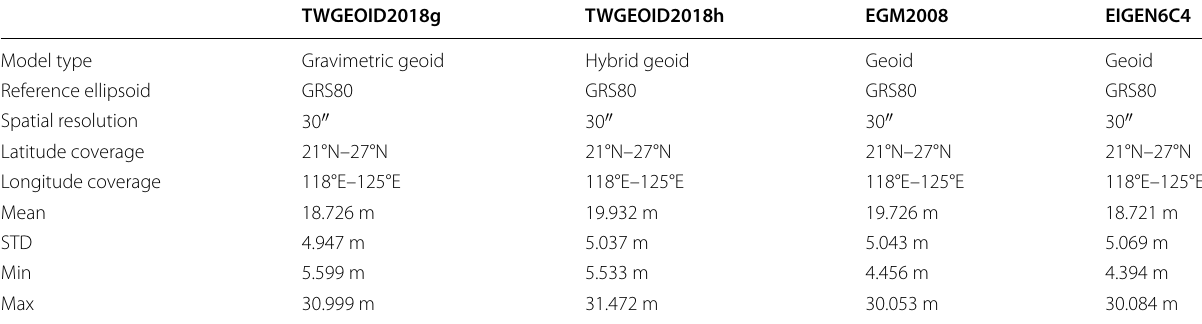
Table 6 Characteristics and statistics of the TWGEOID2018 geoid model (gravimetric and hybrid versions) and the EGM2008 and EIGEN6C4 global models (over the Taiwan area), considered in the local and global geoid comparison example